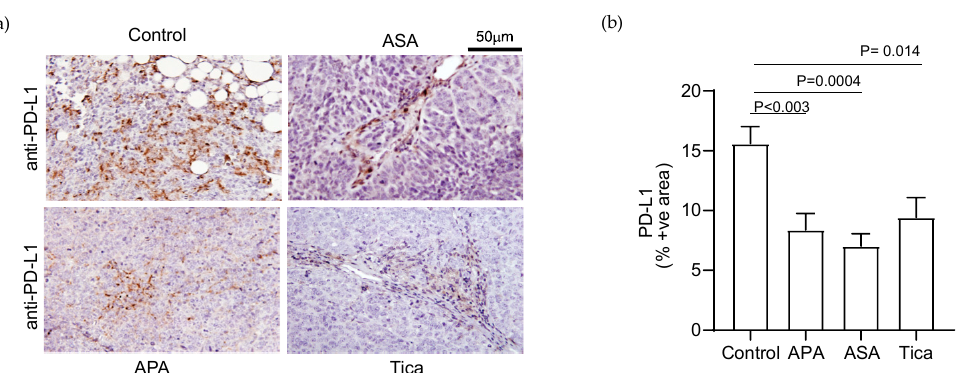
(Figure 2a,b) as compared to controls (TPO-RA = 17.2 ± 2.6%).